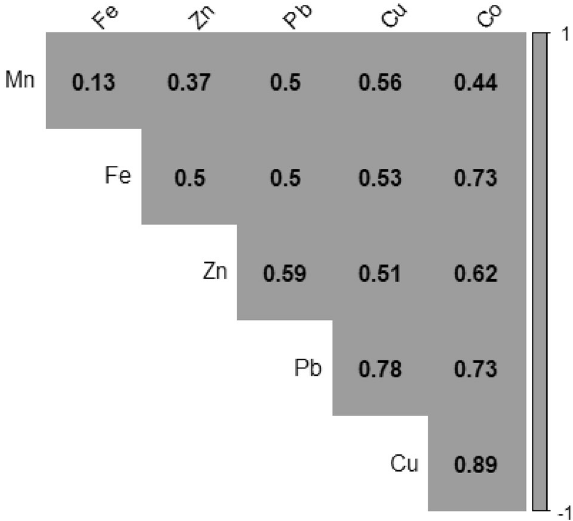
Figure 6. Pearson’s correlation matrix for the heavy metals in mine soil based on sampling points across dumpsites, including the baseline.